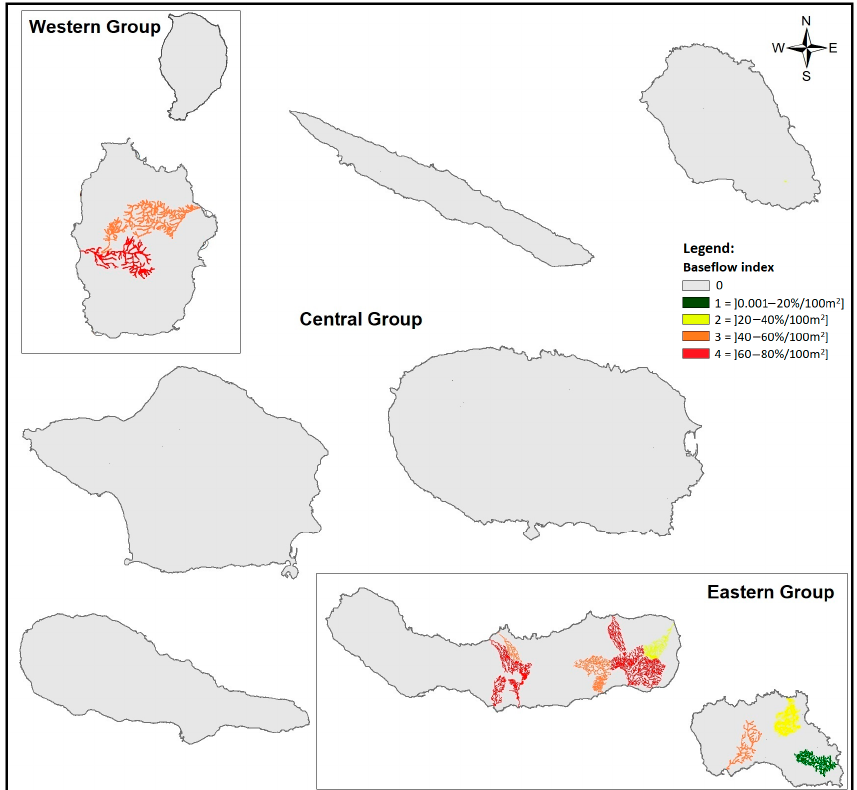
Figure 4. Mapping of the variables that compose the ecosystem dependence index: river baseflow.